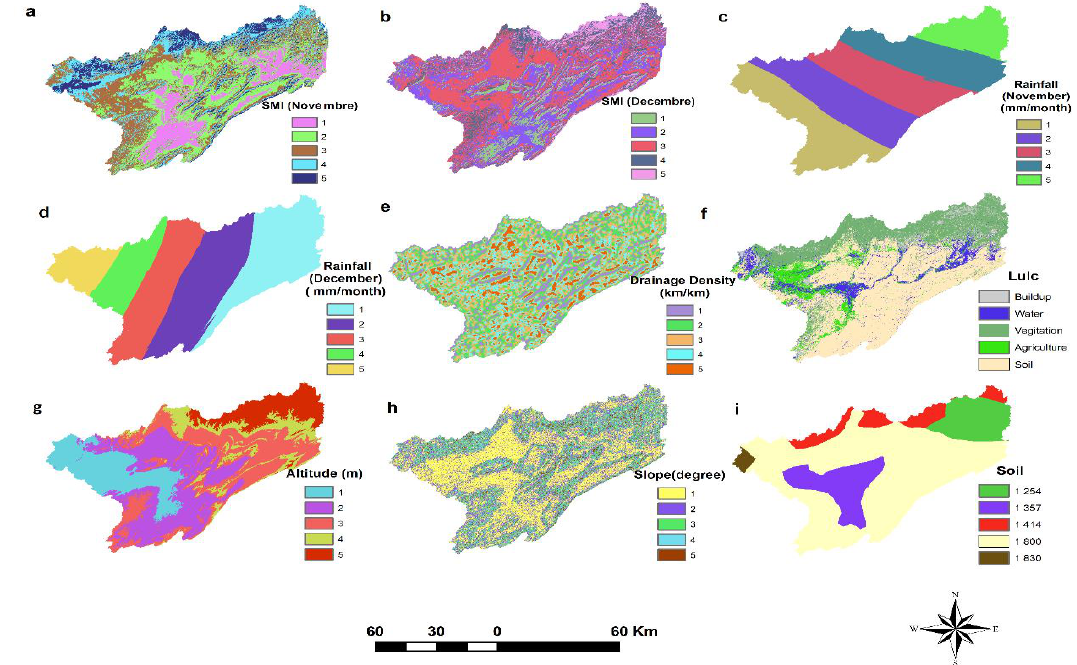
Figure 2. Flash flood conditioning factors used to create the flash flood susceptibility maps: a) SMI before flood (November 2014), b) SMI after flood (December 2014), c) Rainfall before flood (November 2014), d) Rainfall after flood (December 2014), e) Drainage density, f) Lulc , g) Altitude , h) Slope degree, i) Soil